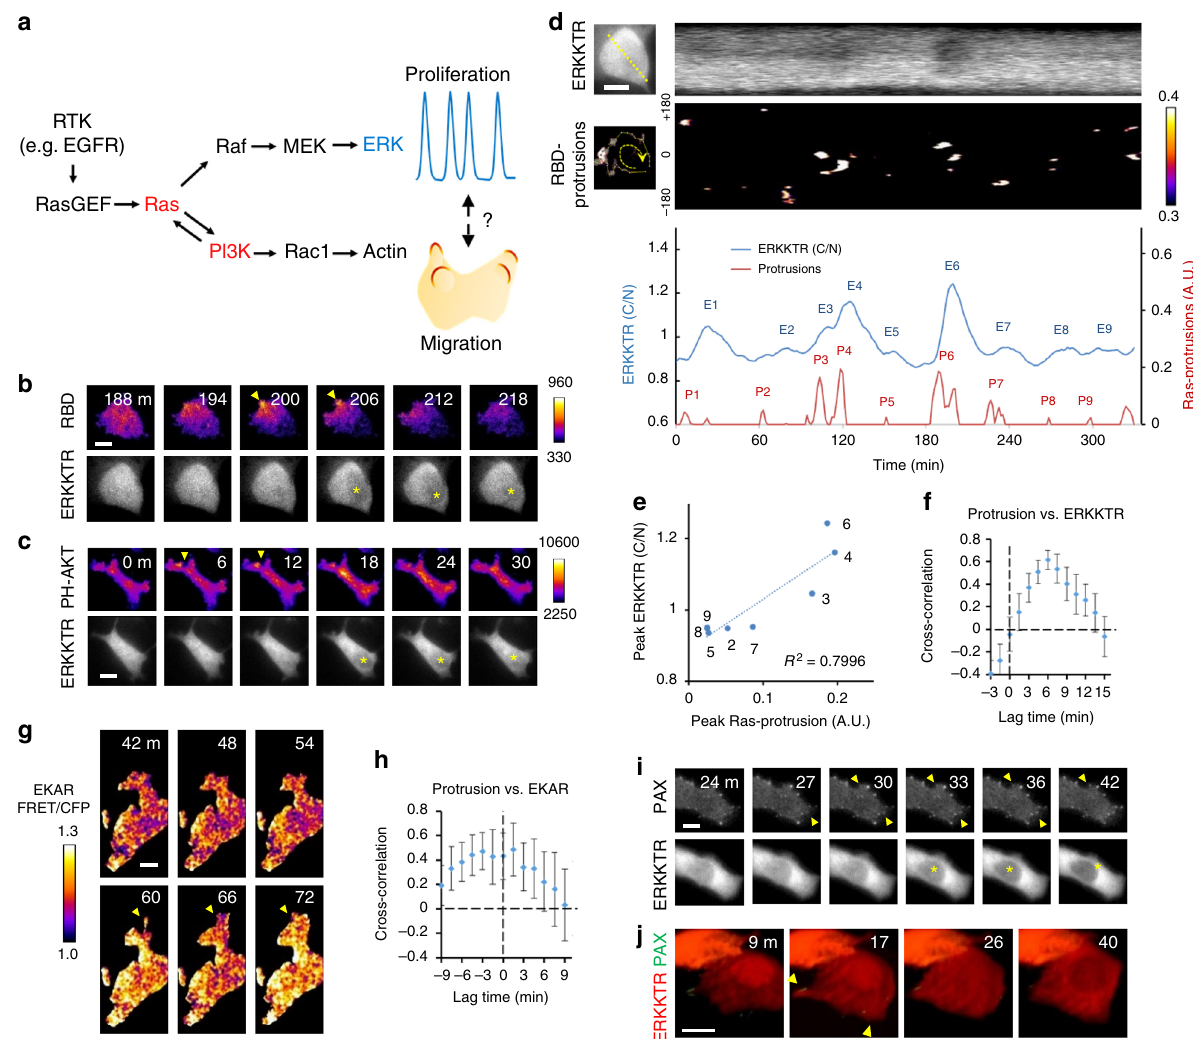
Fig. 1 Spatiotemporal relationship between ERK pulses and protrusions. a The RTK-Ras-PI3K-MAPK/ERK signaling network. ERK displays pulsatile activation to drive proliferation (blue), whereas Ras-PI3K activity propagates as reaction-diffusion waves on the membrane (red) to drive the generation of protrusions during cell migration. b , c Time-lapse epi fl uorescence images of ERKKTR along with TIRF images of FP-tagged RBD ( b ) and PH-AKT ( c ) in MCF7 cells showing protrusions (arrowheads; color scale: fl uorescence intensity (A.U.)) associated with nuclear exit of ERKKTR (asterisks). d Upper kymograph: temporal evolution of ERKKTR fl uorescence along the dashed line across the nucleus. Lower kymograph: RBD-enriched protrusions (color scale: intensity (A.U.) identi fi ed by FDM, see Methods) around the perimeter of the same cell (corresponding to Supplementary Movie 4). Quanti fi cation of cytoplasmic to nuclear ratio (C/N) of ERKKTR (blue) vs. integrated intensity of RBD-enriched protrusions (red) over 6 h of imaging is shown below. E1 – E9 mark peaks of ERKKTR (C/N); P1 – P9 mark protrusive activities preceding E1 – E9. e Plot of the magnitude of ERKKTR (C/N) peaks vs. that of RBD- enriched protrusions. The numbers correspond to the peaks in d . f Cross-correlation analysis of the lag between protrusions and ERKKTR (mean ± s.e.m., n = 12). g TIRF images of an MCF7 cell expressing EKAR, a FRET probe for ERK activation. h Cross-correlation analysis of the lag between protrusions and EKAR (mean ± s.e.m., n = 9). i An MCF7 cell expressing paxillin-GFP (TIRF) and ERKKTR-RFP (epi fl uorescence). j LLSM images of an MCF7 cell showing new paxillin-associated protrusions (arrowhead) associated with ERKKTR nuclear exit (see also Supplementary Movie 5). Scale bars: 10 µ